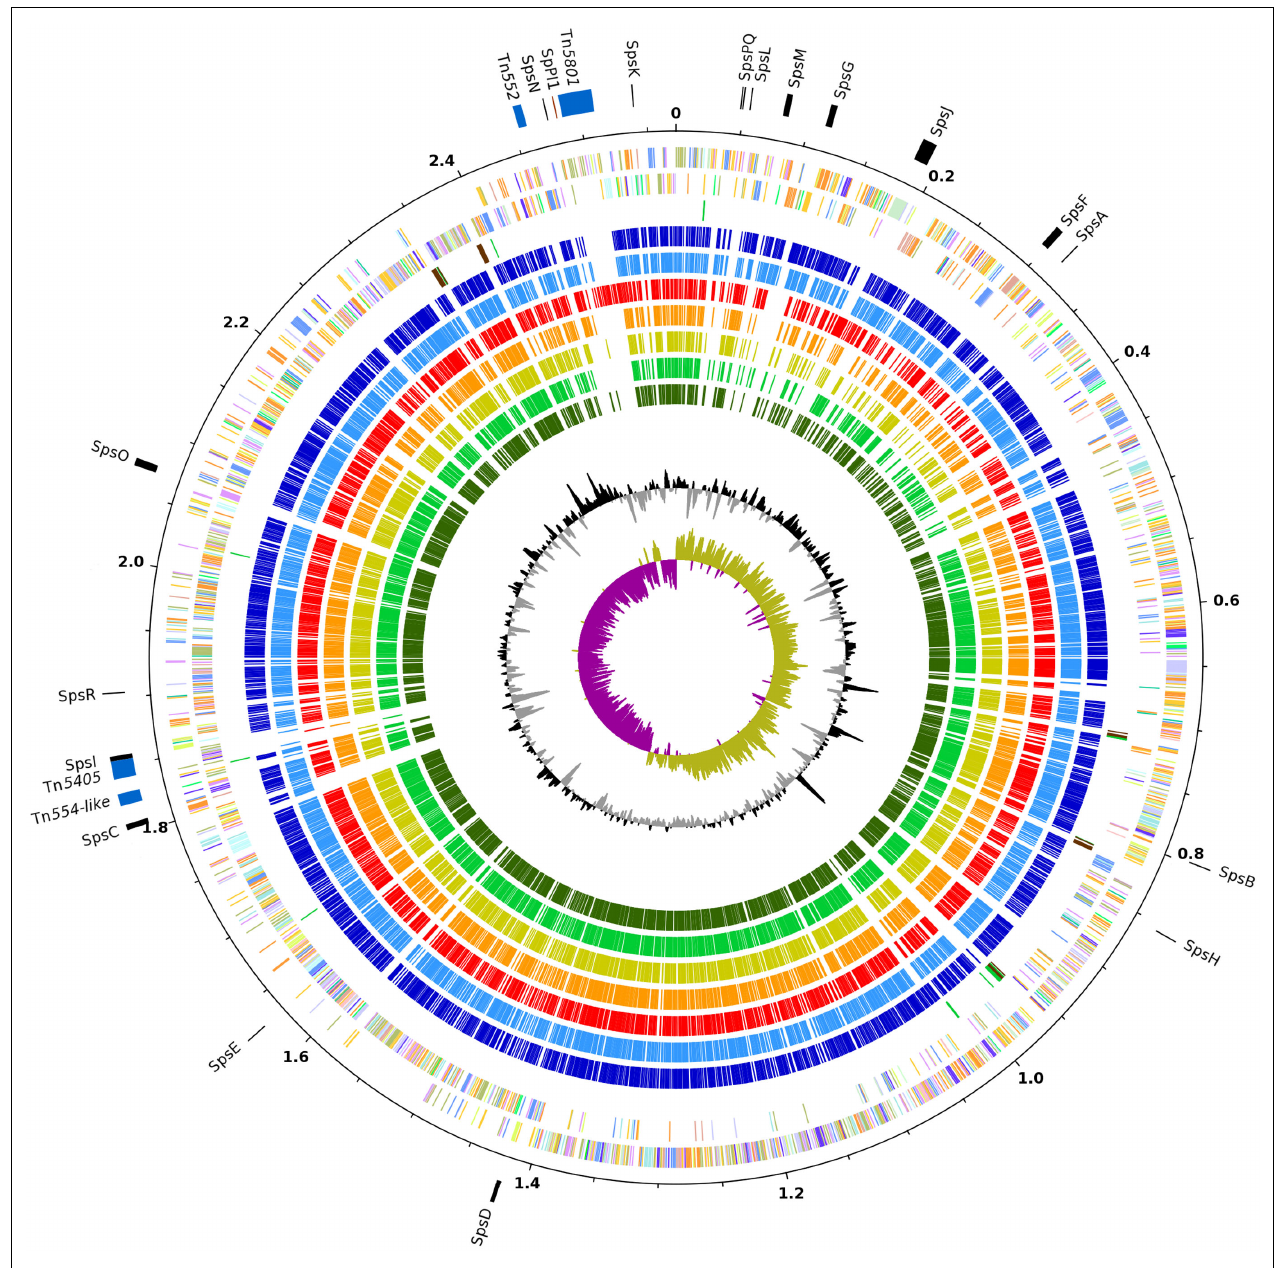
(colored according to their COG category); circle 4, tRNA (green), rRNA (brown); circle 5, S. delphini 8086 (dark blue); circle 6, S. intermedius NCTC11048 (blue); circle 7, S. aureus Mu50 (red); circle 8, S. epidermidis RP62A (orange); circle 9, S. haemolyticus JCSC1435 (yellow); circle 10, S. saprophyticus ATCC15305 (light green); circle 11, S. carnosus TM300 (dark green); circle 12, G + C content plot (black and gray); and circle 13, GC skew plot (purple and